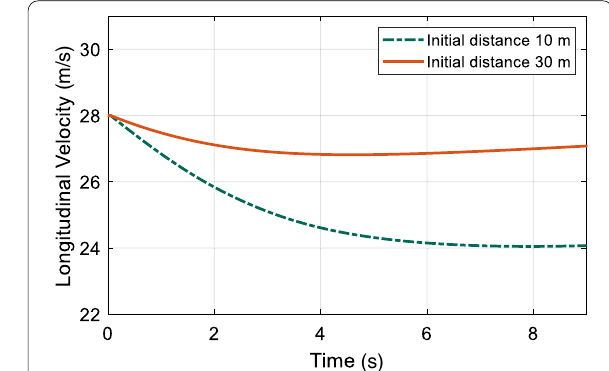
Figure 10 Vehicle positions at the trajectory crossing point when initial longitudinal distance is 10 m